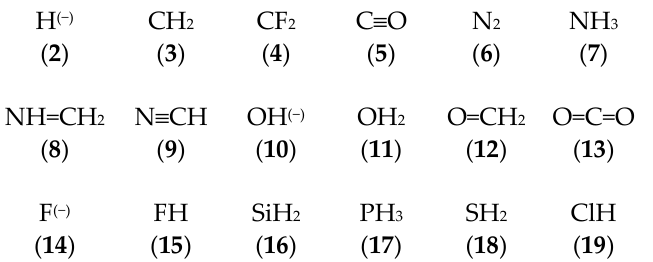
vertex in the carbenoid ( 1 ) with a series of electron donor molecules and anions leading to tetrel C-X bonds. The chosen 18 LB systems, including the anions H ( − ) , F ( − ) , and OH ( − ) , are displayed below in Scheme 1 with the corresponding label.